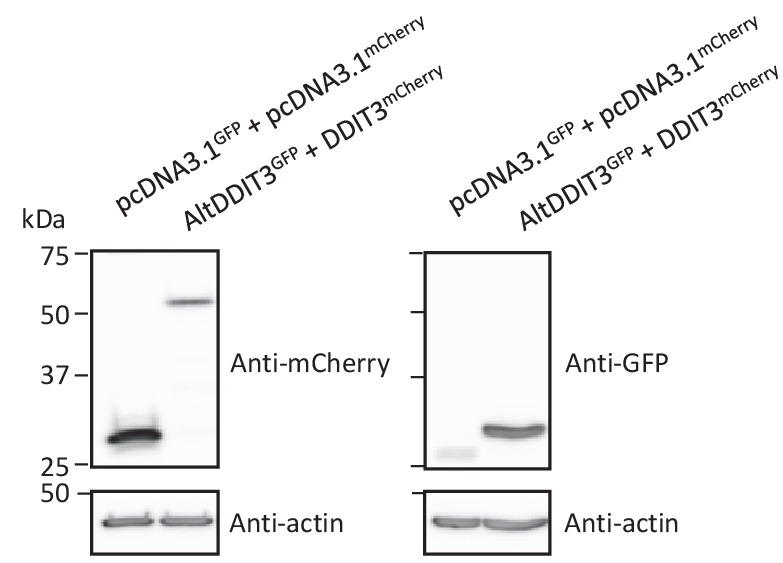
Protein immunoblot showing the expression of different constructs in HeLa cells.HeLa cells were co-transfected with GFP and mCherry, or altDDIT3GFP and DDIT3mCherry, as indicated. Proteins were extracted and analyzed by western blot with antibodies, as indicated. Molecular weight markers are shown on the left (kDa). AltDDIT3 has a predicted molecular weight of 4.28 kDa and thus migrates at its expected molecular weight when tagged with GFP (~32 kDa). Representative experiment of two independent biological replicates.